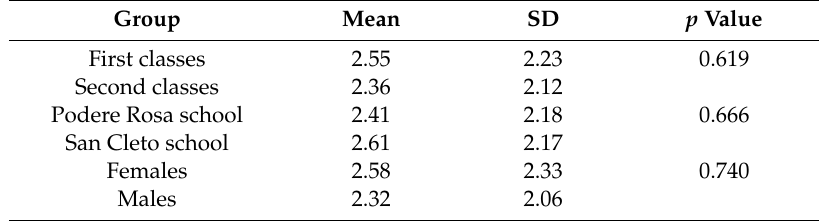
Table 2. Di ff erences in delta knowledge scores, calculated by T-test for matched